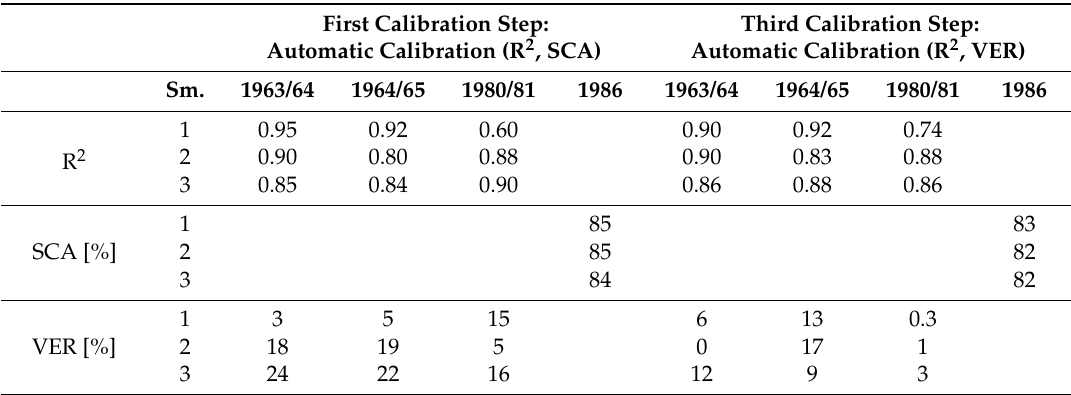
Table 3. Objective functions of each sample (Sm.) of the two automatic calibration runs (Bold: Used as calibration year, Grey: Used as objective